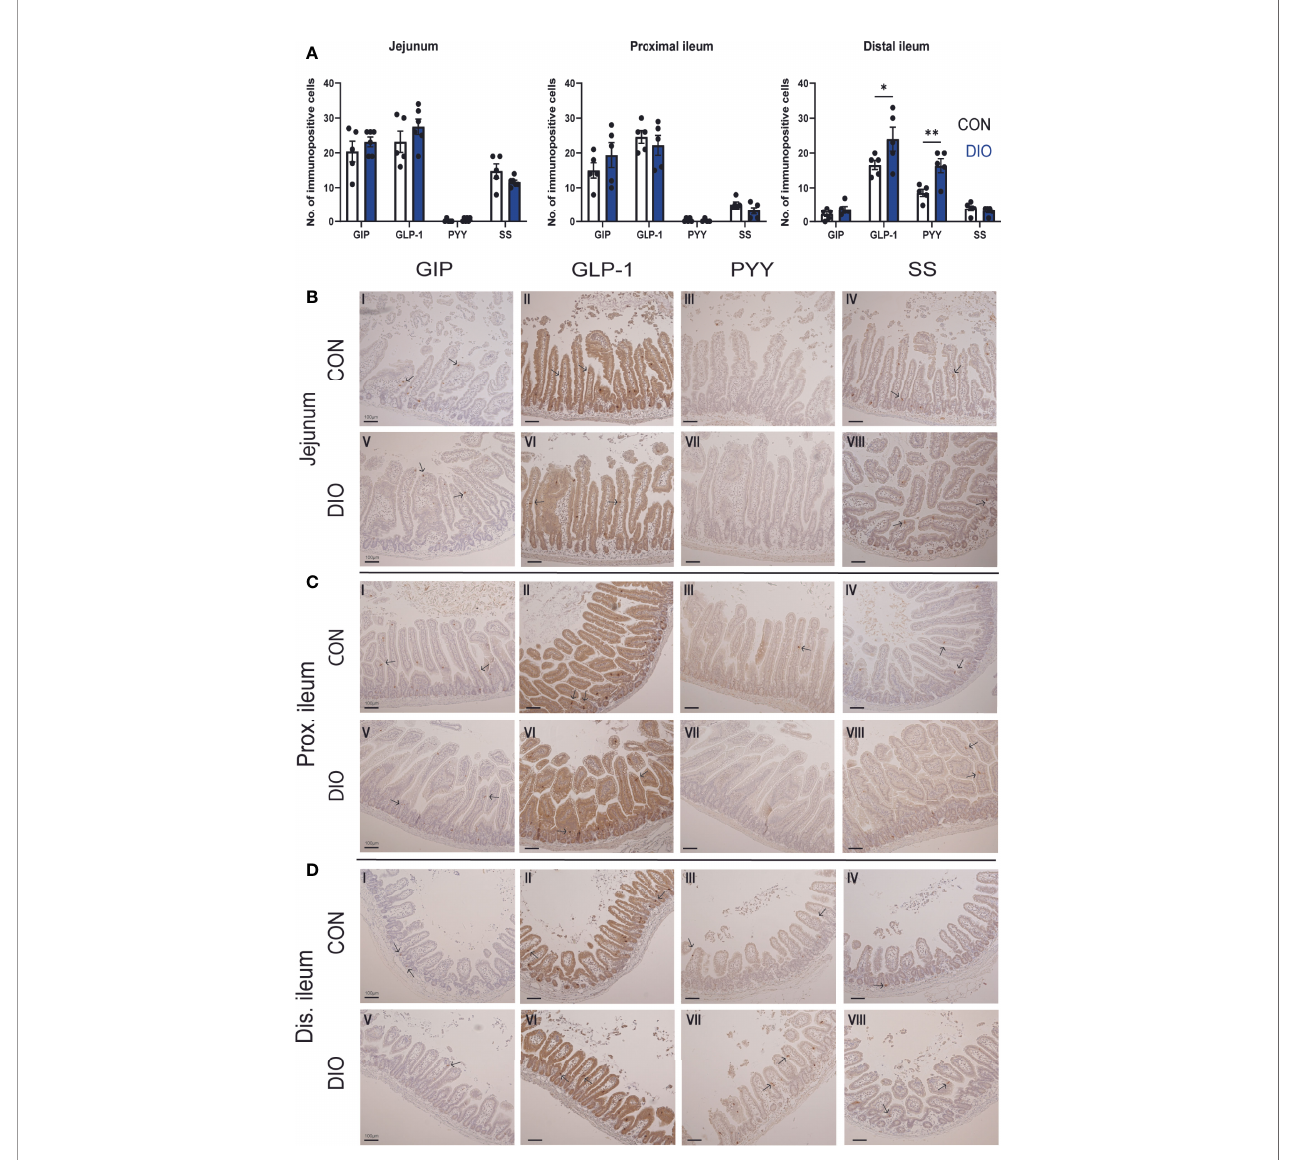
FIGURE 2 | Immunohistochemical comparison of K-, L- and D-cells in the jejunum and ileum of control vs. DIO mice. (A) The number of GIP, GLP-1, PYY, and SS immunopositive cells in the jejunum and proximal and distal ileum in control mice (white bars, n = 5) or DIO mice (blue bars, n = 5 – 6). Data are presented as mean ± SEM, and statistical signi fi cance was evaluated by 2-way ANOVA followed by Bonferroni ’ s multiple-comparison test, *p < 0.05 and **p < 0.01 (B – D) Histological appearances and IHC for GIP, GLP-1, PYY, and SS in the jejunum, proximal and distal ileum of control vs. DIO mice. Scale bar corresponds to 100